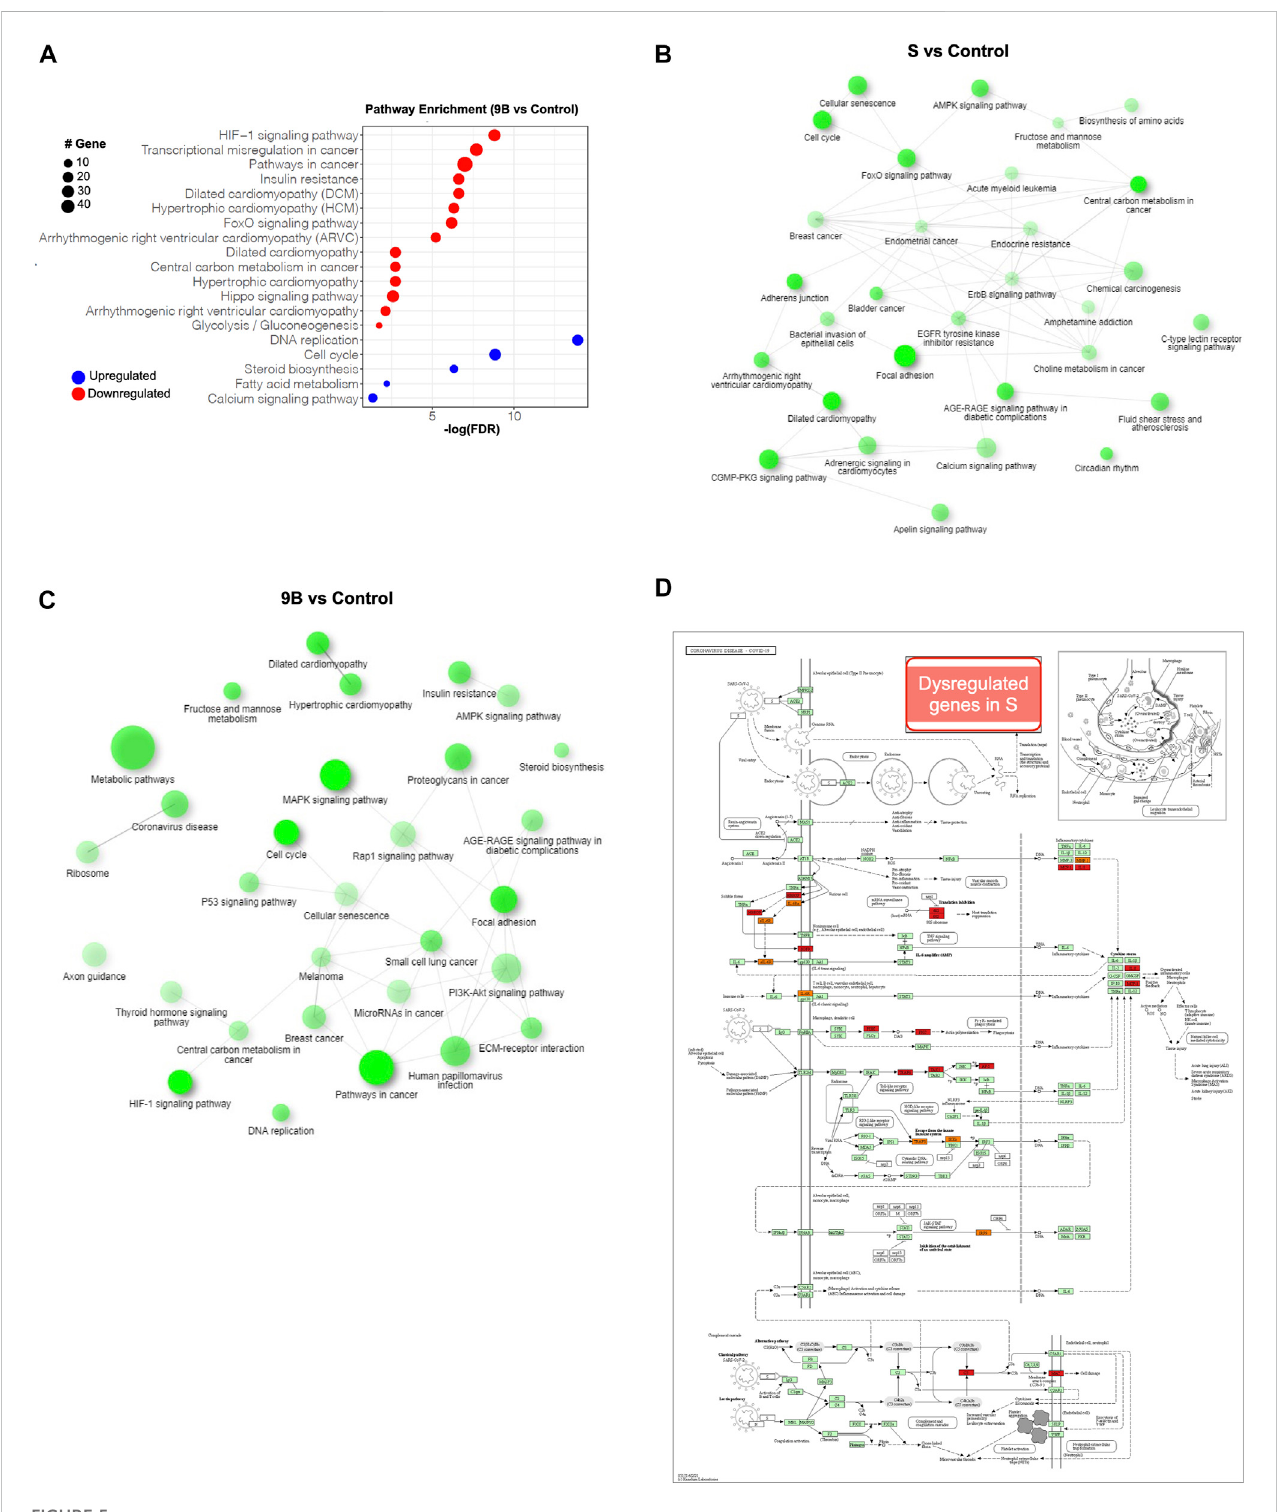
Pathway analysis of the differential genes in CMs after overexpression of SARS-CoV-2 subunits. (A) KEGG analysis of dysregulated genes in CMs of ORF- 9B group. Y -axis shows statistically enriched (FDR < 0.05) KEGG pathways ranked by FDR. The red dots represent upregulated genes, and the blue dots represent downregulated genes. The size of the dot represents number sizes of dysregulated genes. (B, C) Interactive KEGG pathways (FDR < 0.05) from dysregulated genes from theORF-9B group (B) and S groups (C) . (D) The KEGG map illustratesthedysregulated genes from S group that are involvedin the “ coronavirus disease ” pathway. Red, upregulated genes; blue, downregulated